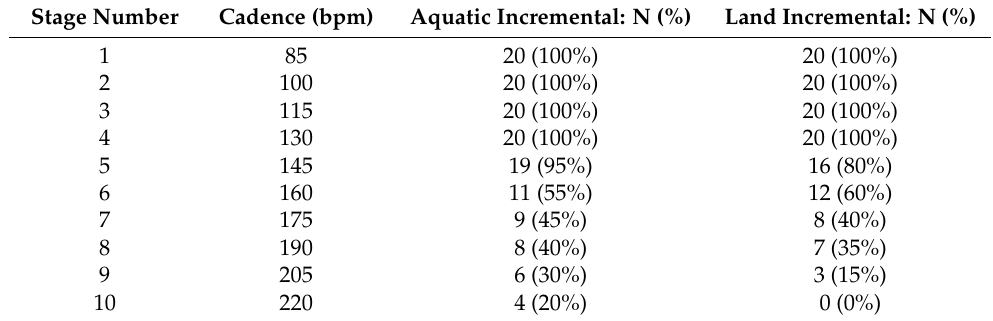
Table 2. Number of participants who reached each stage of the aquatic and land incremental